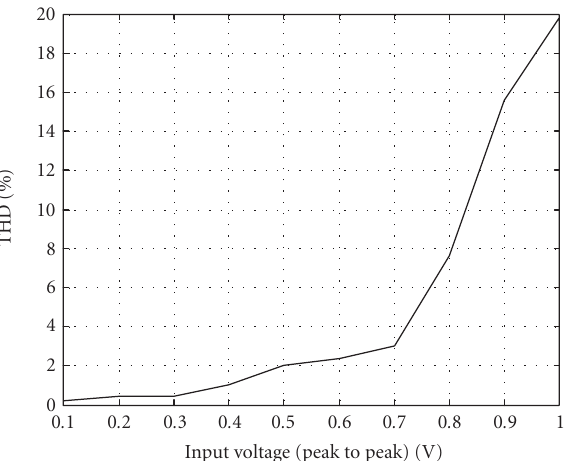
Figure 6: THD variations of the BP filter versus amplitudes of the applied sinusoidal voltages at